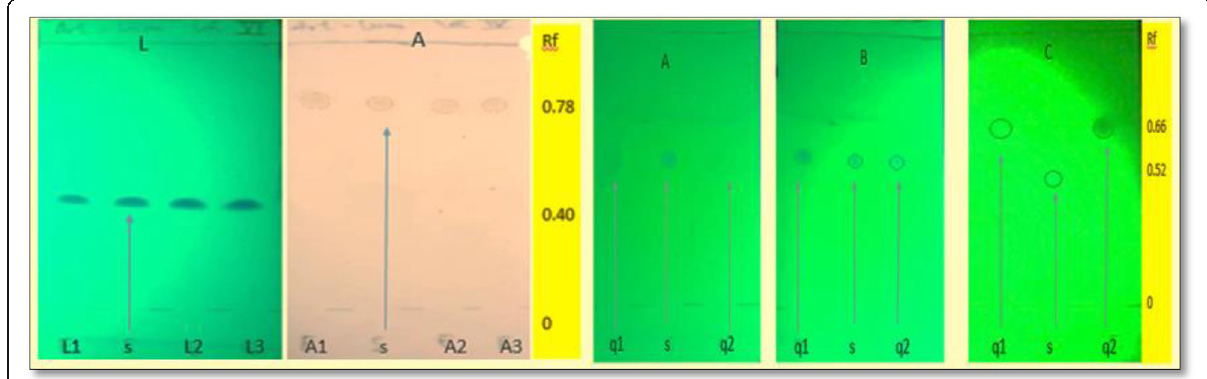
Fig. 1 Typical TLC chromatograms of Artemether (A)/Lumefantrine (L) samples at the left and three quinine samples (A, B, C) at right. The TLC of Lumefantrine (L) and Artemether (A) shows that all batches in triplicate spots gave Rf similar to the standards(s), with Rf error < 2% for all the spots. However, the TLC of quinine shows the absence of quinine sulfate in sample spot A(q2); the similarity of B(q1) and B(q2) spots with the standard (s); the presence of other products different from the quinine standard in C(q1) and